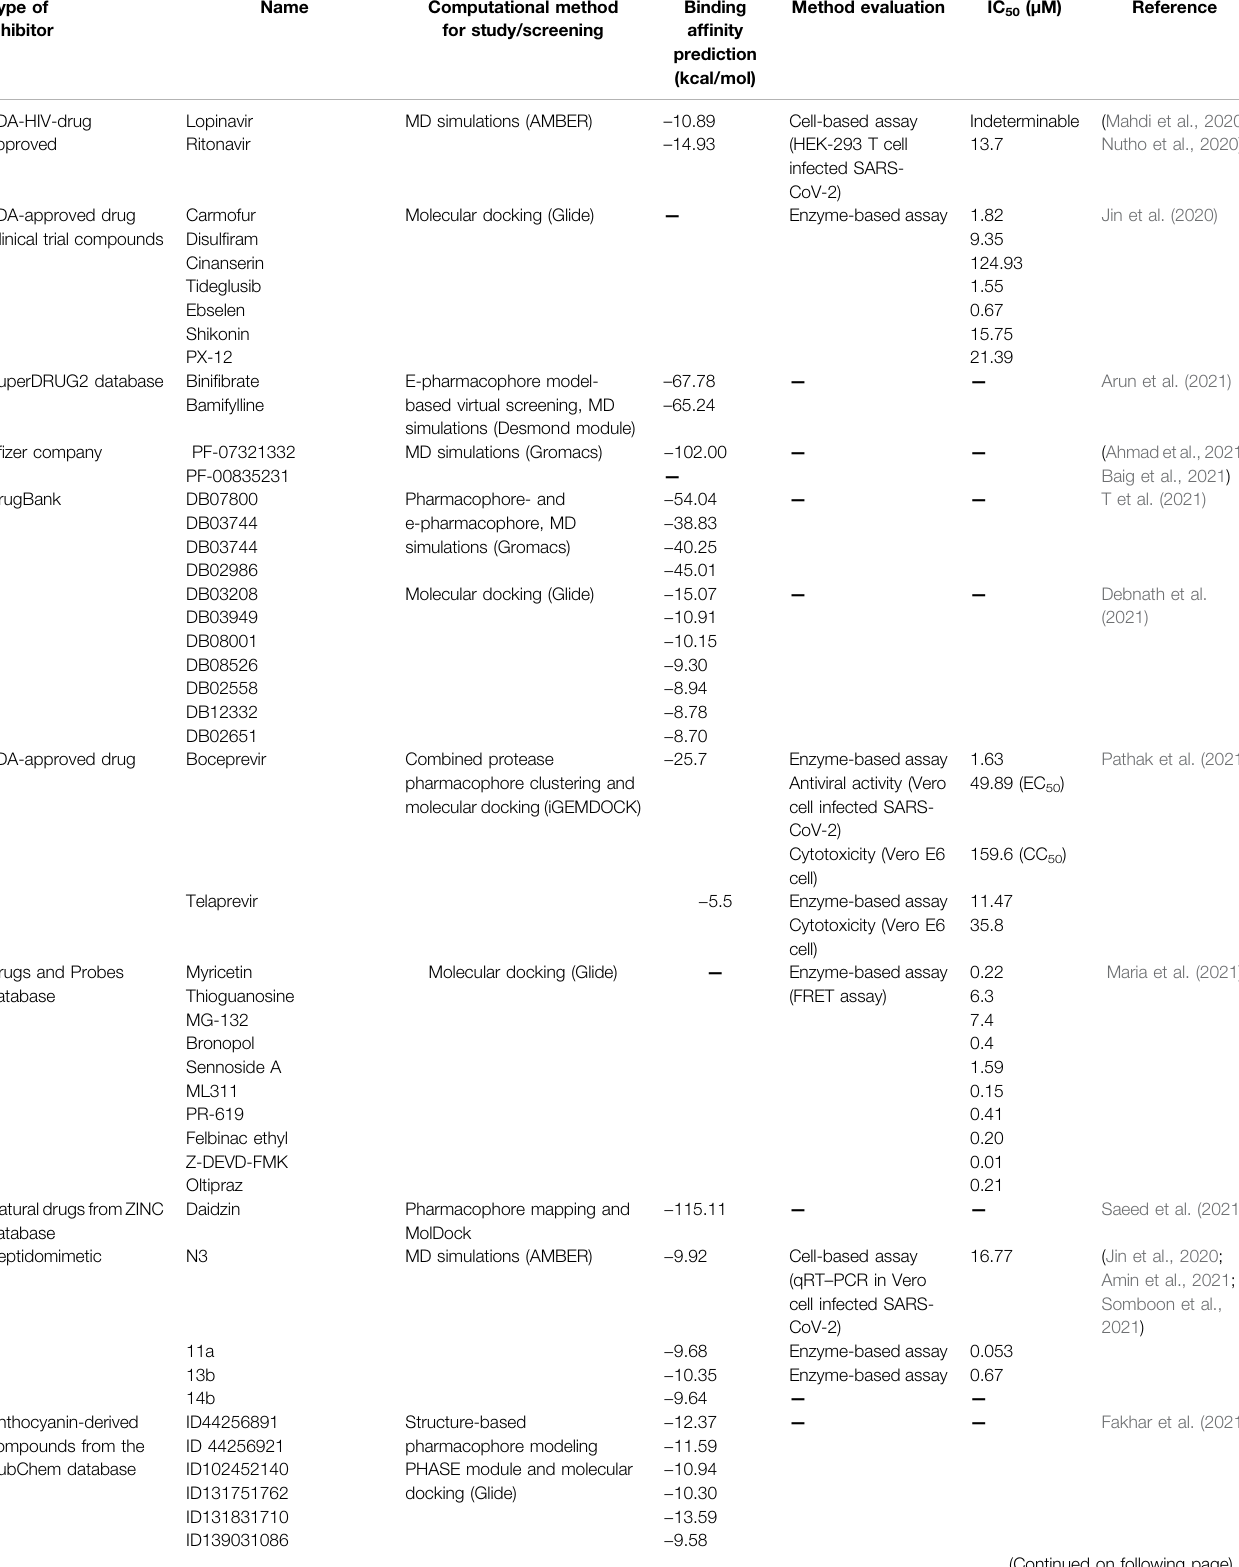
TABLE 5 | Inhibitors against SARS-CoV-2 Mpro derived from in silico screening. Type of